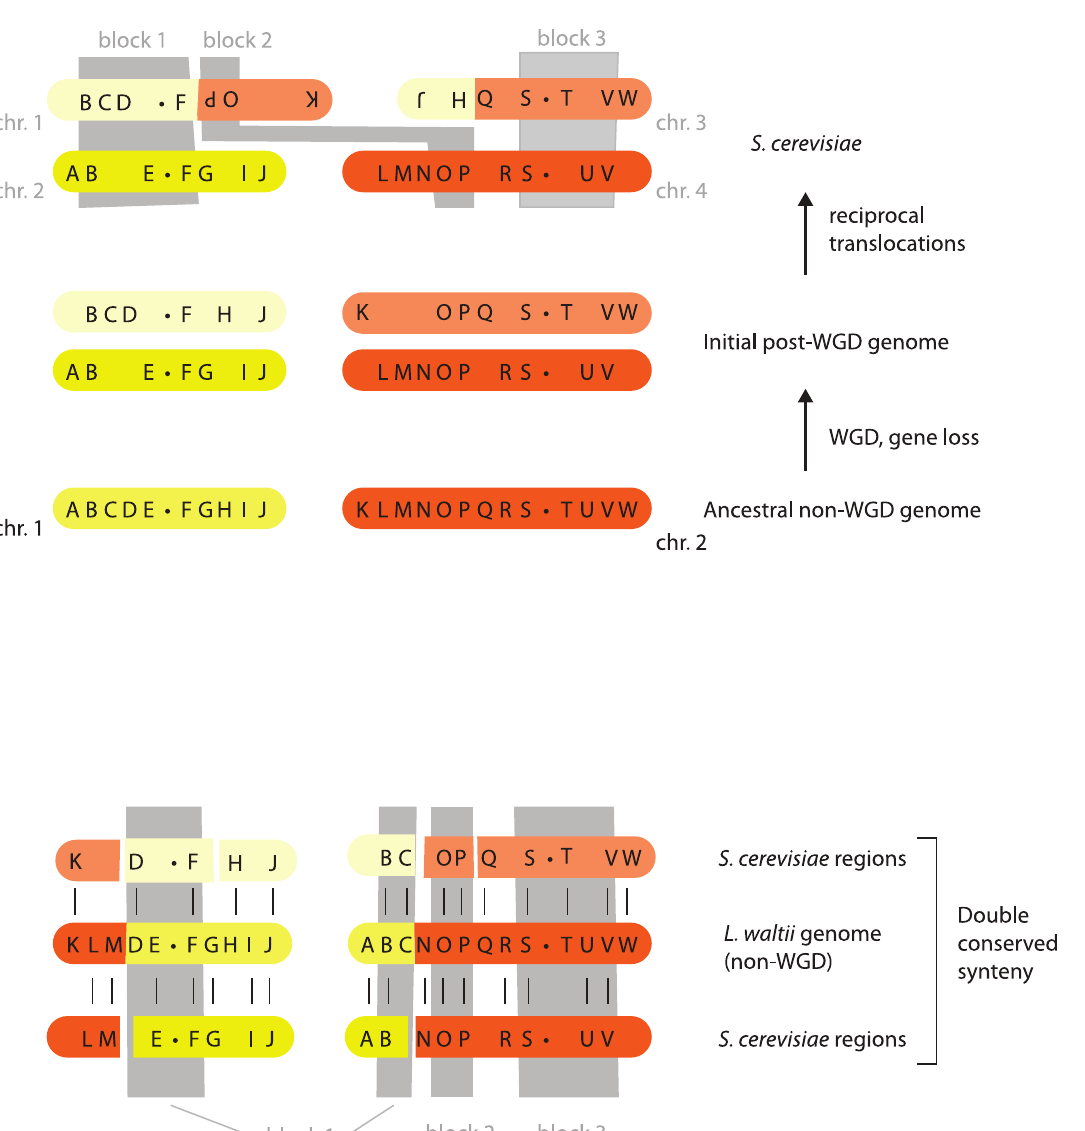
Fig 1. A simple model of WGD, gene loss, and synteny relationships. The upper panel shows how duplicated blocks were initially identified using only genes that remain in duplicate in S . cerevisiae [4]. The lower panel shows how additional data from non-WGD yeasts such as Lachancea waltii [5] allowed the parts of the genome that were not initially allocated to blocks to be placed into pairs, providing a duplication map that covered the whole S . cerevisiae genome. Letters A – W represent genes, and dots represent centromeres. Only two chromosomes (yellow and brown) are